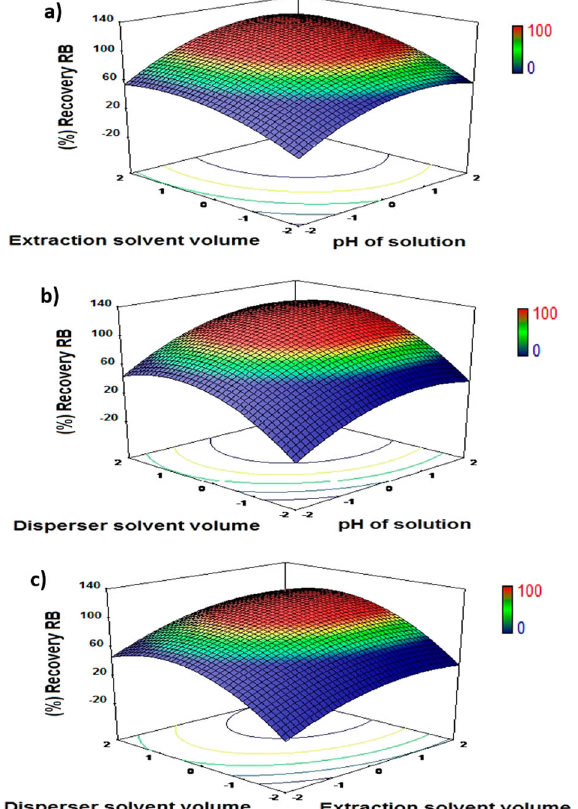
Fig. 5 The response surface plots showing the effects of variables on extraction of RB. a The interaction of extraction solvent volume and pH of solution, b the interaction of disperser solvent volume and pH of solution, c the interaction of disperser solvent volume and extraction solvent volume (experimental conditions: ionic strength: 0.0 – 10.0 w/v%, extraction solvent: chloroform (50 – 250 µL), sonica- tion time: 1 – 5 min, dispersive solvent: ethanol (200 – 1000 µL), pH: 3 – 7, water sample volume: 10 mL, centrifuge rate: 3500 rpm, spiked concentration: 500 ng mL − 1 ).